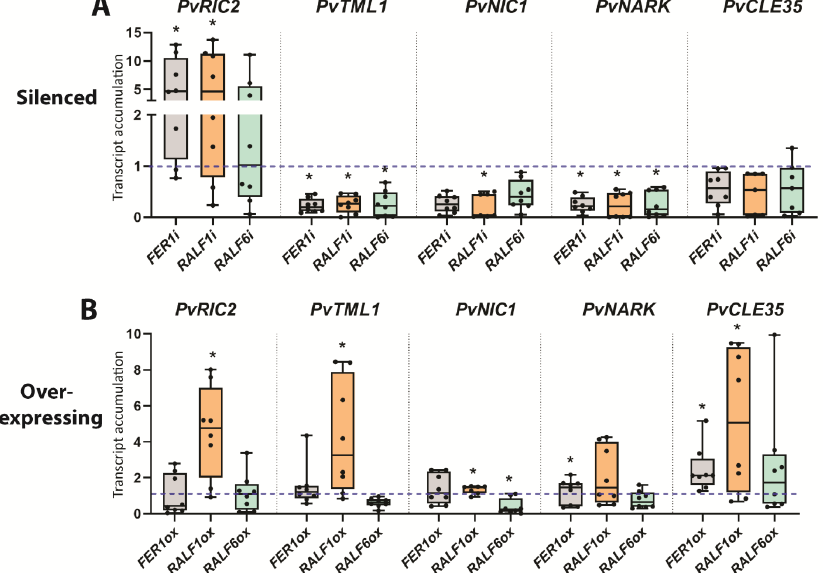
Figure 7. Positive regulation of genes related to AON and NRN by PvFER1, PvRALF1, and PvRALF6 under high-nitrate conditions. ( A , B ) Accumulation levels of AON ( PvRIC2 and PvTML ) and NRN ( PvNIC , PvNARK , and PvCLE35 ) marker gene transcripts in PvFER1 - (gray boxes), PvRALF1 - (orange boxes), and PvRALF6 -silenced (green boxes) ( A ) and -overexpressed ( B ) transgenic roots at 21 dpi under 5 mM nitrate. The blue dotted line represents the levels of the transcripts in the control roots for the five genes analyzed. The upper and lower edges of the boxes delimit the first to third quartiles, the horizontal line within the box represents the median, and the whiskers indicate the smallest and largest outlier in the data set. Data from three independent experiments are represented as points ( n ≥ 8). A non -parametric Mann – Whitney test was used to assess significant differences. * p < 0.05. The IDE transcript accumulation was used as the internal reference gene.